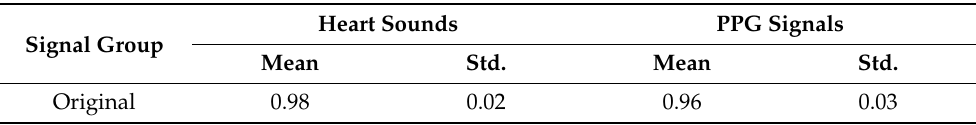
Table 1. Cross-correlation values for heart sounds and PPG signals measured by the prototype device and the MP160.